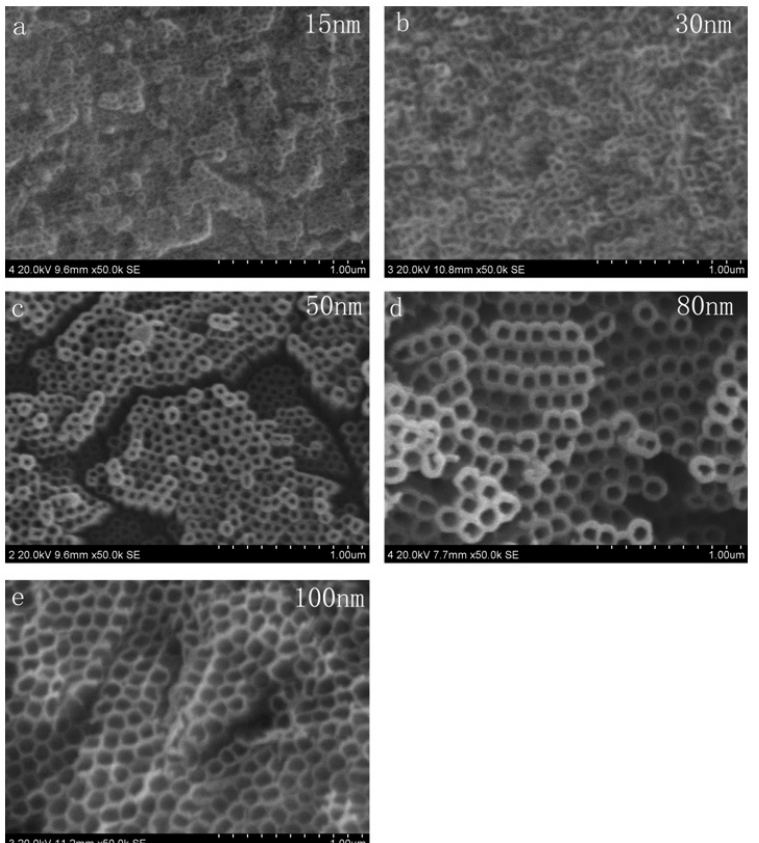
Figure 1. SEM micrographics of morphology of TiO by different oxidation voltages: ( a ) 20 V; ( b ) 30 V; ( c ) 40 V; ( d ) 50 V; ( e ) 60